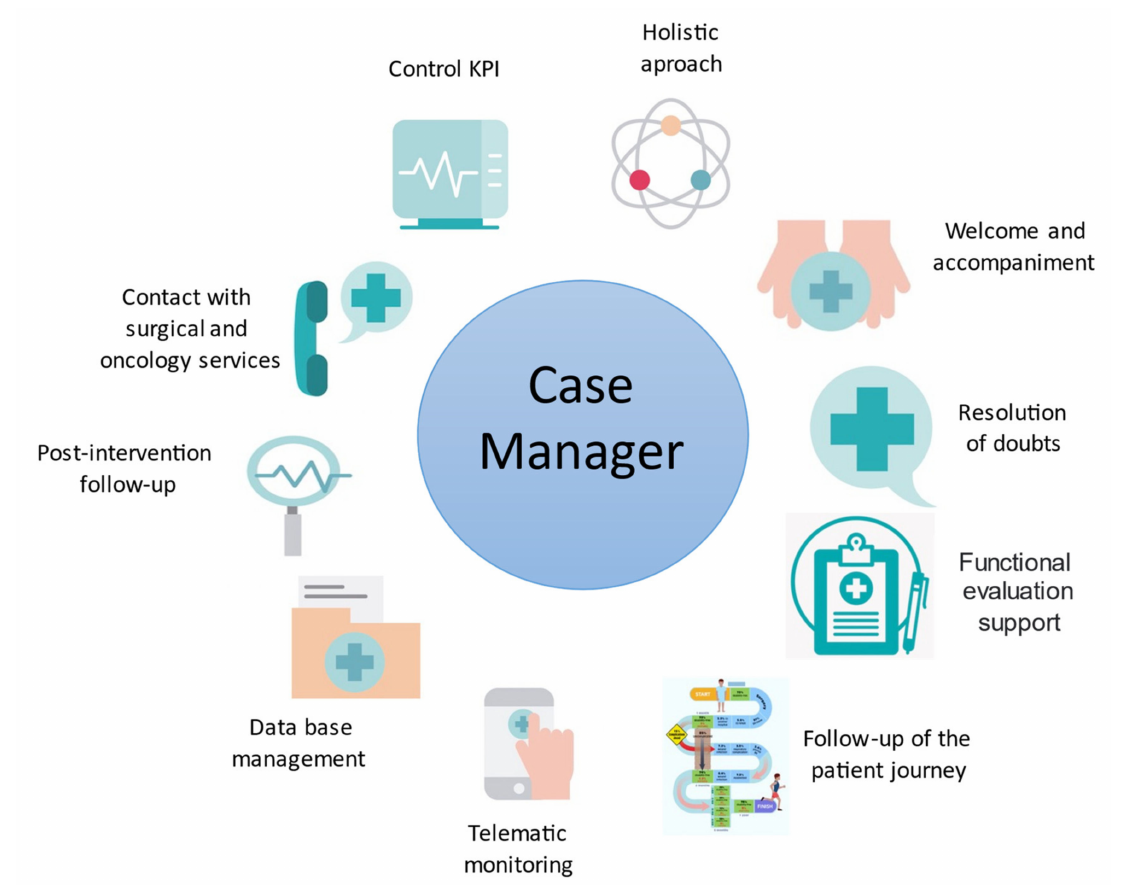
Figure 2. Case manager tasks in the Prehabilitation